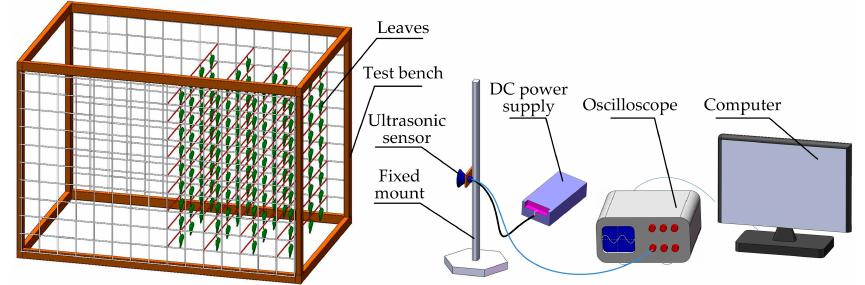
Figure 2. Diagram of target density detection system .